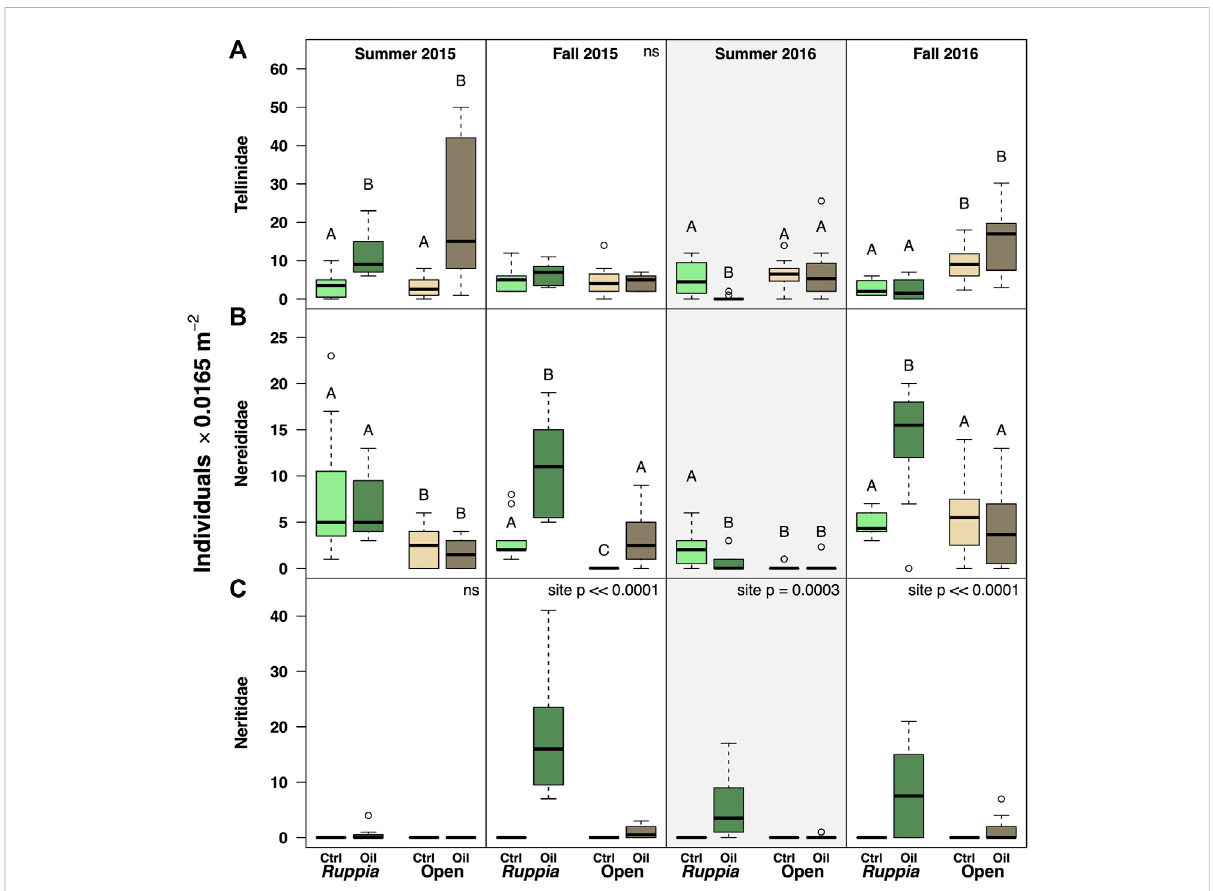
FIGURE 5 Abundance data for families that showed positive responses to oiling (A) Tellinidae (Mollusca: Bivalvia). (B) Nereididae (Annelida). (C) Neritidae (Mollusca:Gastropoda), here represented by Neritina usnea . The Summer 2016 panels are highlighted to emphasize the reoiling event observed at that time. Boxes with different letters are different by Tukey post-hoc tests.